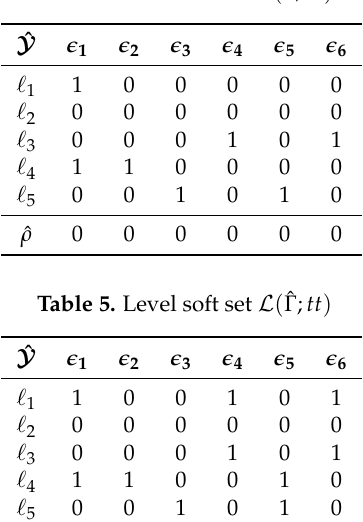
Table 4. Level soft set L ( ˆ Γ ; tb )